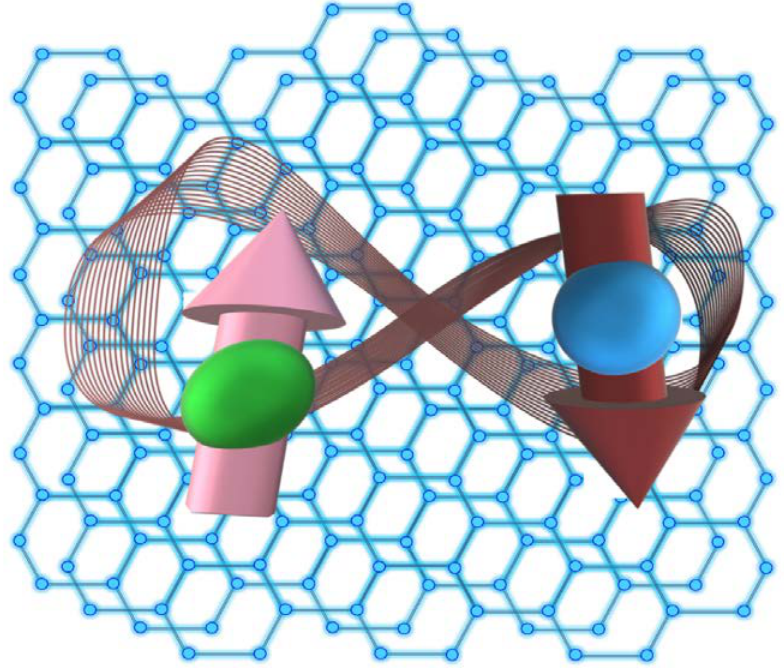
Figure 6. Spin visualization for hybrid material TIs.